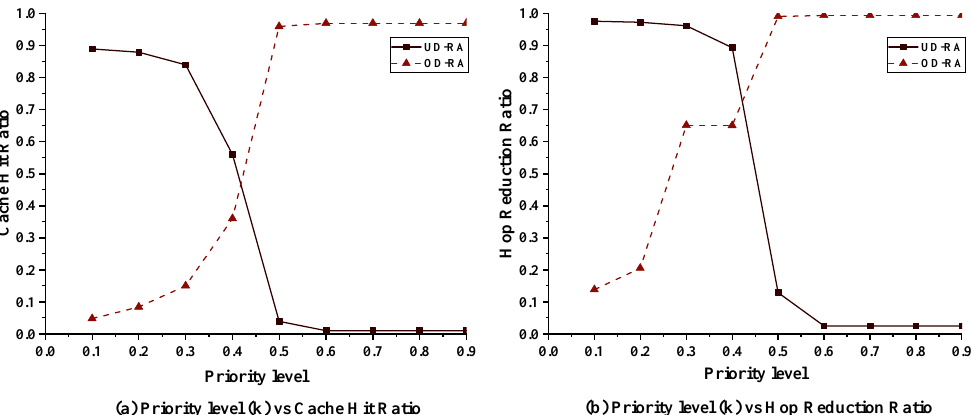
Figure 4. Caching performance vs. priority level in terms of ( a ) cache hit ratio, and ( b ) hop reduc- tion ratio.